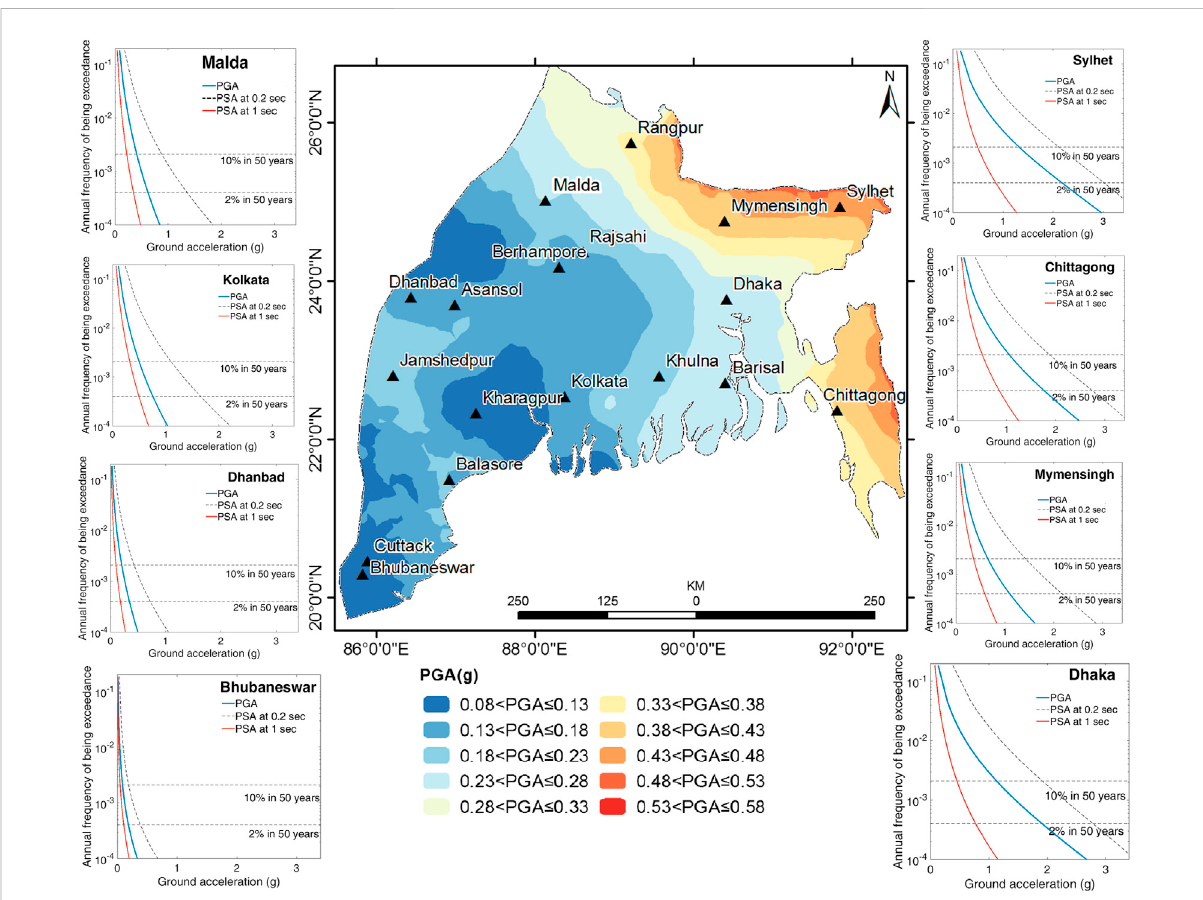
FIGURE 5 Peak ground acceleration distribution at the fi rm rock condition for 10% probability of exceedance in 50 years together with hazard curves for thecities ofDhanbad,Kolkata, Bhubaneswar,Malda, Mymensingh, Chittagong,Sylhet, and Dhaka correspondingto PGA(blue bold line), PSAat0.2 s (dotted black line), and 1.0 s(red bold line) at engineering bedrock with 10% and 2% probability of exceedance in 50 years demarcated by the dotted horizontal line in the diagram presenting 475 and 2,475 years of the return